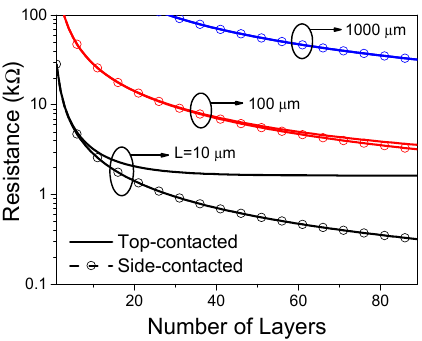
Figure 3. E ff ective resistances of top-contacted and side-contacted MLGNR interconnects with Fermi Figure 3. Effective resistances of top-contacted and side-contacted MLGNR interconnects with Fermi level E F = 0.6 eV, specularity parameter p = 1, and c -axis resistivity ρ c = 0.3 Ω · cm [28]. level 𝐸 (cid:3007) = 0.6 eV , specularity parameter 𝑝 = 1 , and c -axis resistivity 𝜌 (cid:3030) = 0.3 Ω ⋅ cm [28].